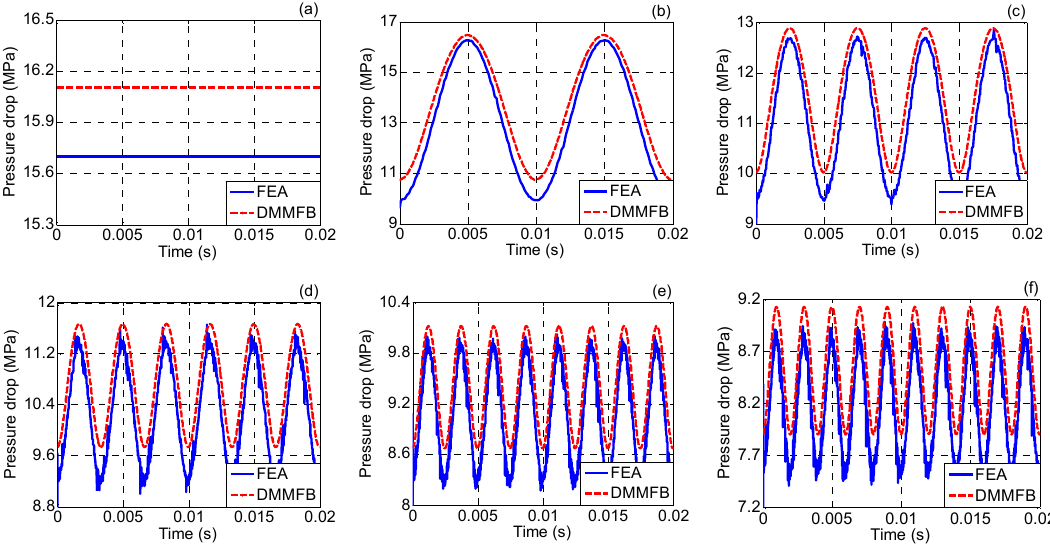
Figure 4. The internal pressure drop of the extrusion liquefier without and with 0.25 g vibration applied at di ff erent frequencies. ( a ) No vibration applied, ( b ) 100 Hz, ( c ) 200 Hz, ( d ) 300 Hz, ( e ) 400 Hz, ( f ) 500